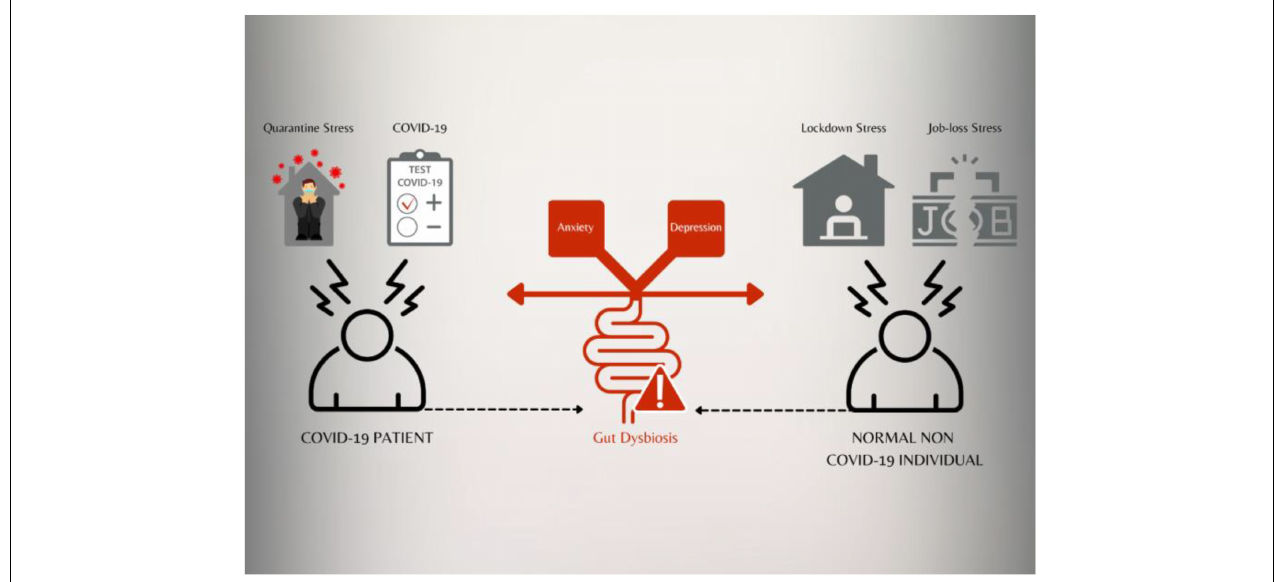
FIGURE 1 | Coronavirus disease 2019 itself and various stressors may impact the gut microbiota which can lead to gut dysbiosis. Gut dysbiosis may be implicated in anxiety and depression both in COVID-19 patients and healthy individuals exposed to various